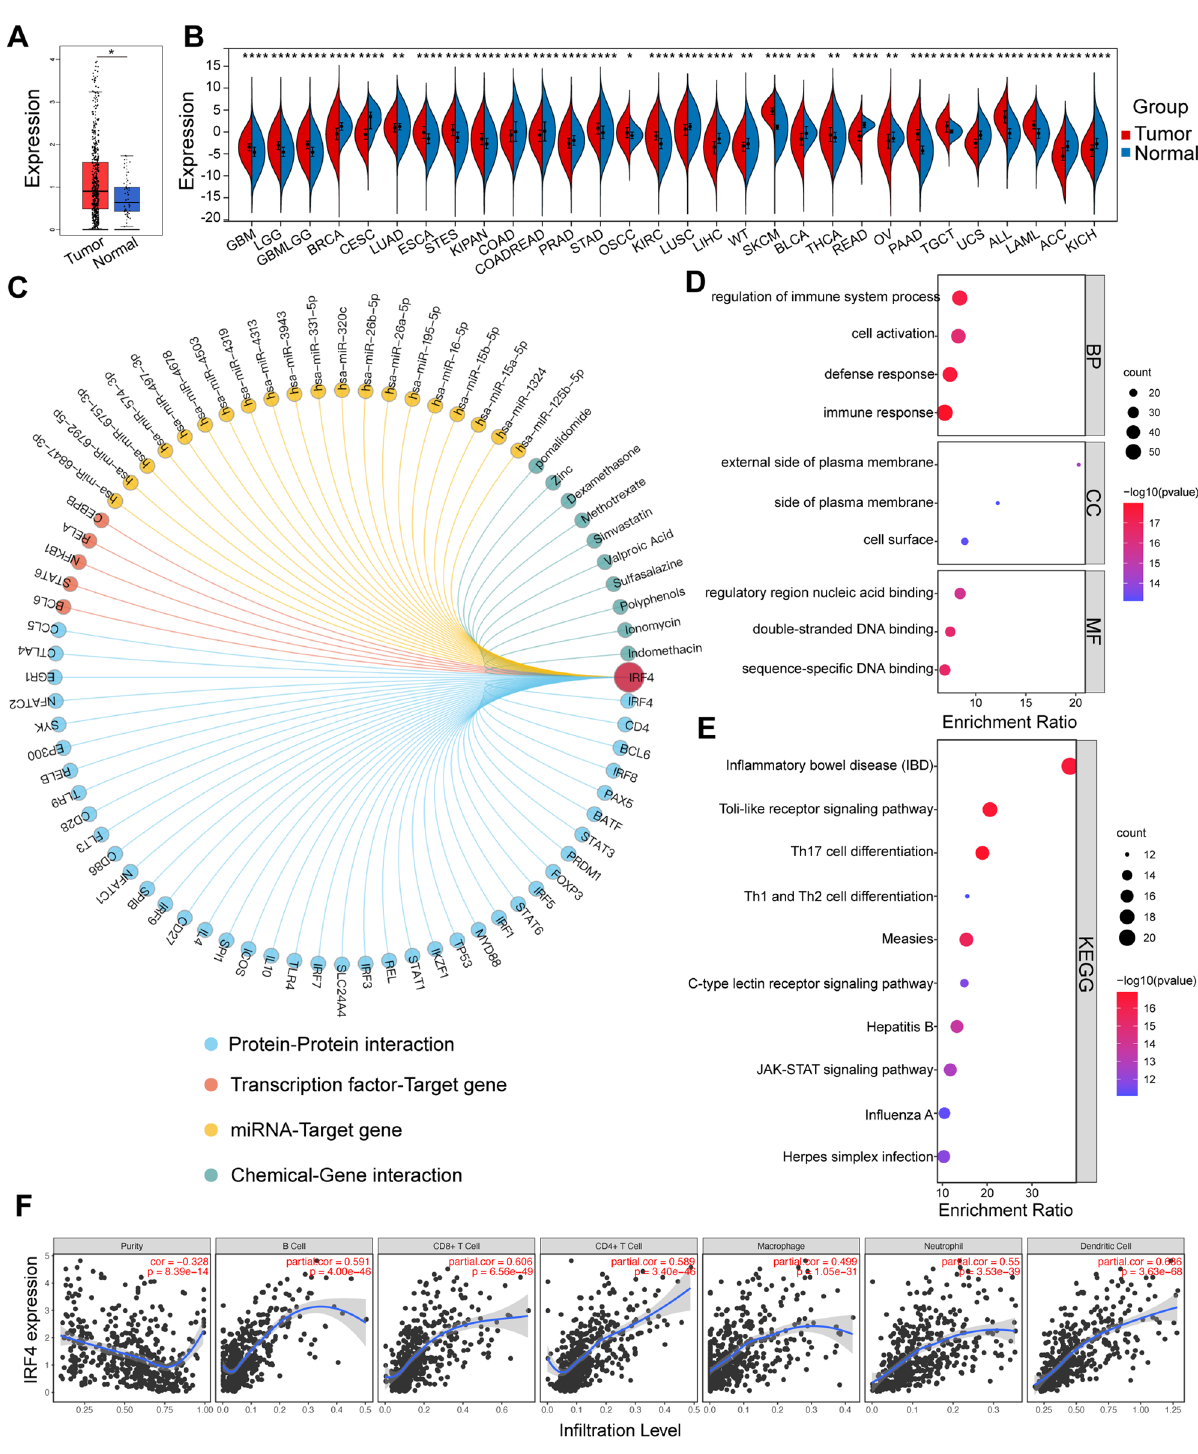
Figure 5. Pan Cancer Analysis and Functional Analysis of IRF4 in OSCC. ( A ) The mRNA expression of IRF4 in OSCC from TCGA database. ( B ) The expression status of IRF4 in different cancers. ( C ) The chord plot showing highly relevant molecules assigned to IRF4. ( D ) GO enrichment analysis of genes interacting with IRF4. ( E ) KEGG pathways analysis of genes interacting with IRF4. ( F ) The correlation of IRF4 and tumor infiltrating immune cells performed via TIMER. * p < 0.05; ** p < 0.01; *** p < 0.001; **** p <